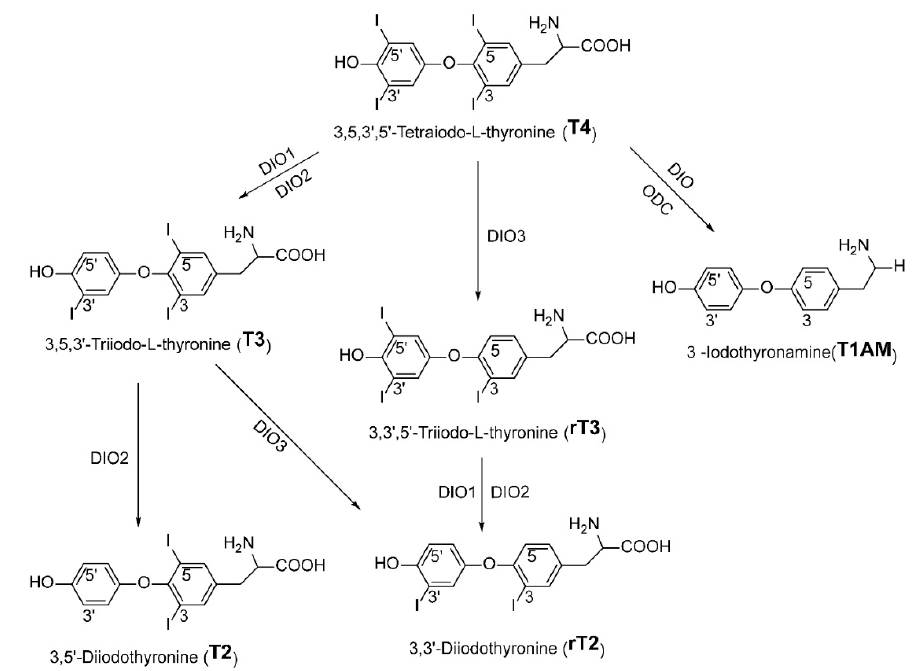
Figure 2. Metabolic pathways of thyroxine (T4). DIO isozymes catalyze reductive sequential removal of iodide from the phenolic. Abbreviations: DIO: iodothyronine deiodinase, and ODC: orni- thine decarboxylase.